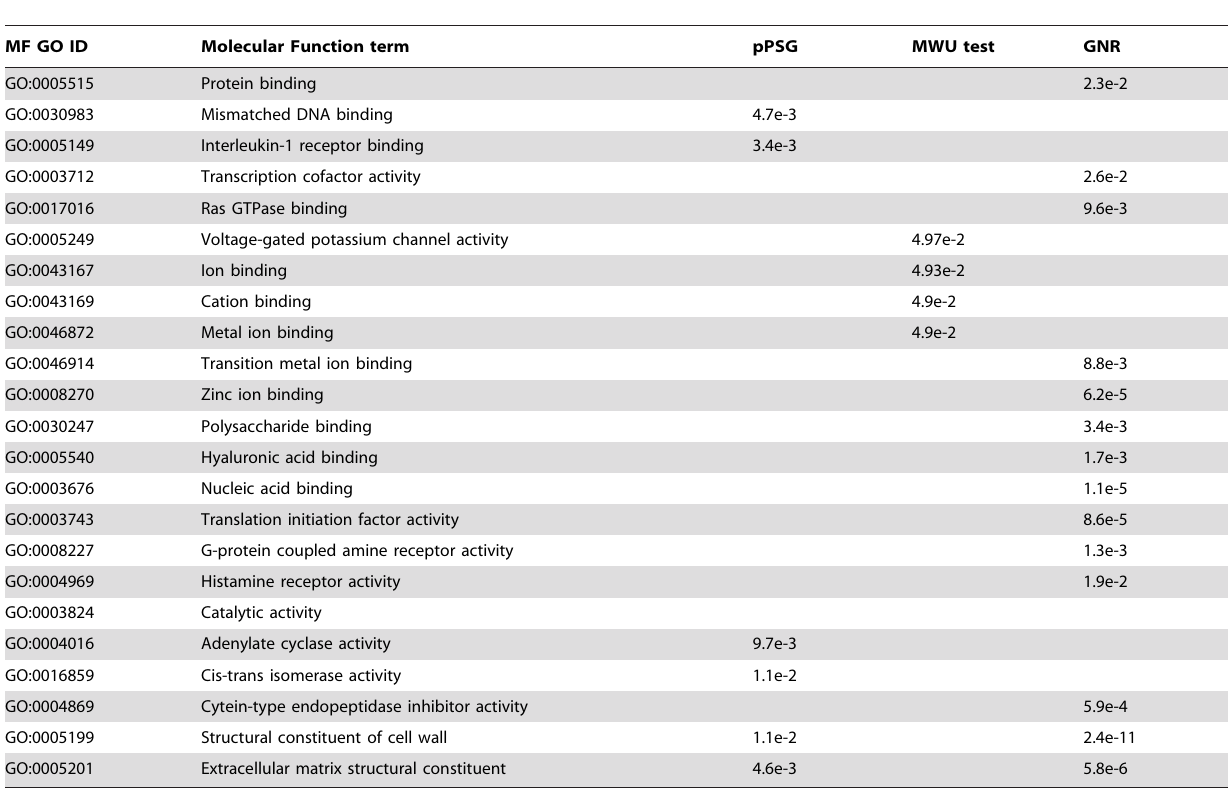
Table 2. Molecular Function GO terms enriched with either pPSG, with genes displaying small P -values as given by the MWU test, or with GNR.